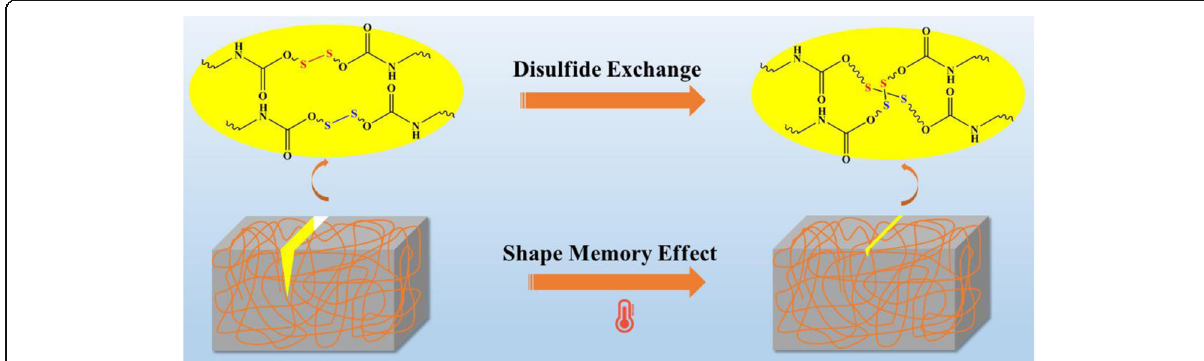
Fig. 1 Illustration of the healing process of the self-healing polyurethane